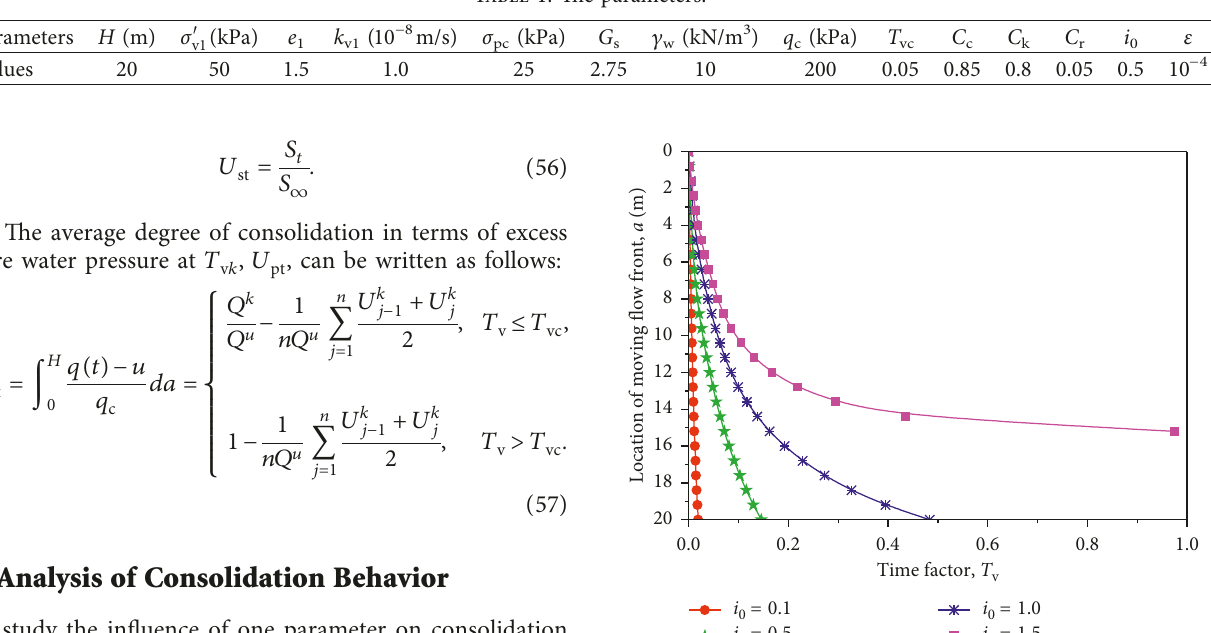
Table 1: The parameters.